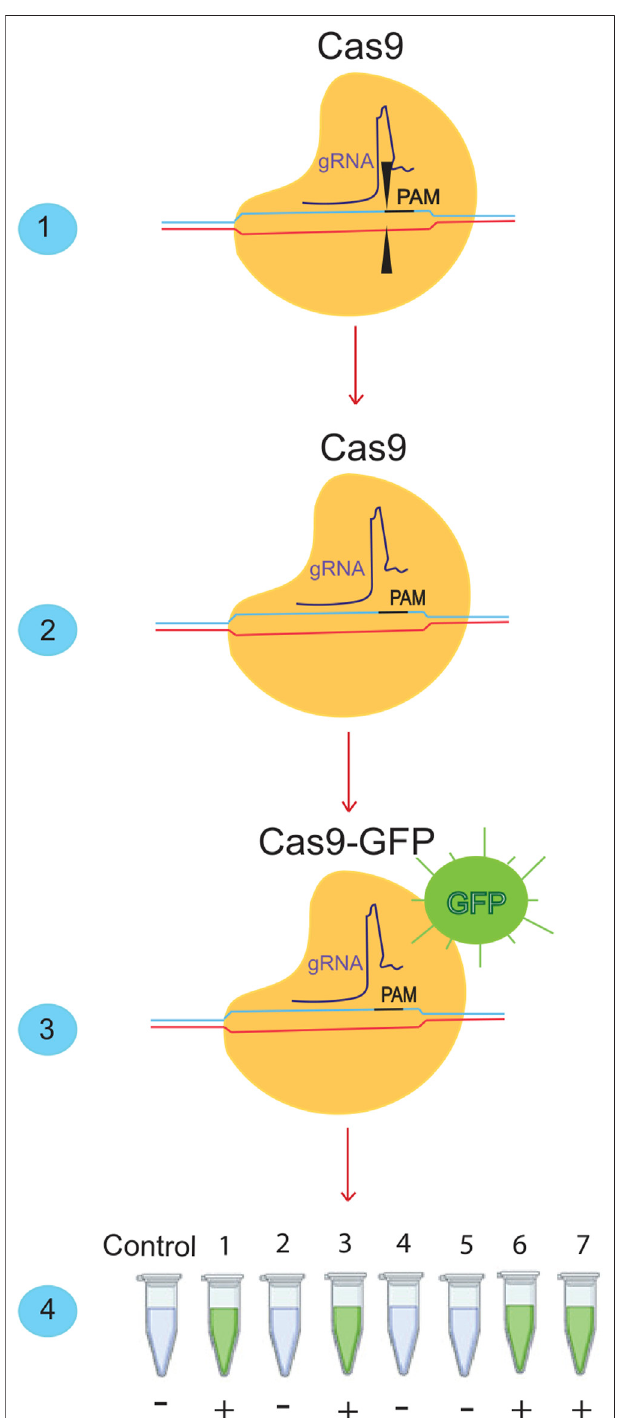
FIGURE 2 | Detection of SARS-cov-2 using the Crisper/Cas system. (1) The Crisper/Cas9 system binds to speci fi c sequences using gRNA. (2) If we remove the cutting effect from this system and (3) add a fl uorescent dye, we can bind it to the desired sequences. When it is bound to the desired sequence, it will produce a green color. (4) With this ability of the CRISPR/ CAS9 system, many SARS-CoV-2 samples can be detected in a short